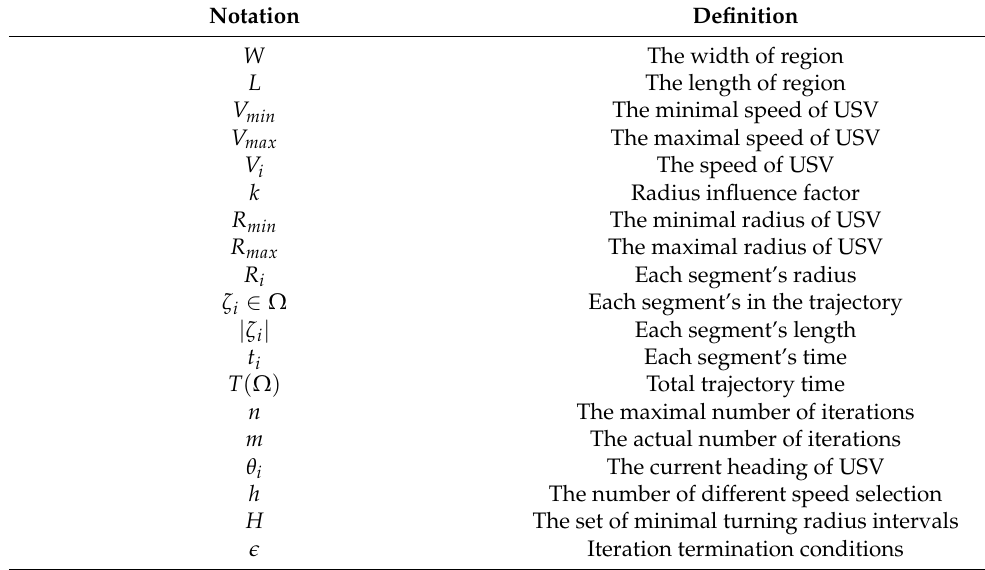
Table 1. Descriptions of the main